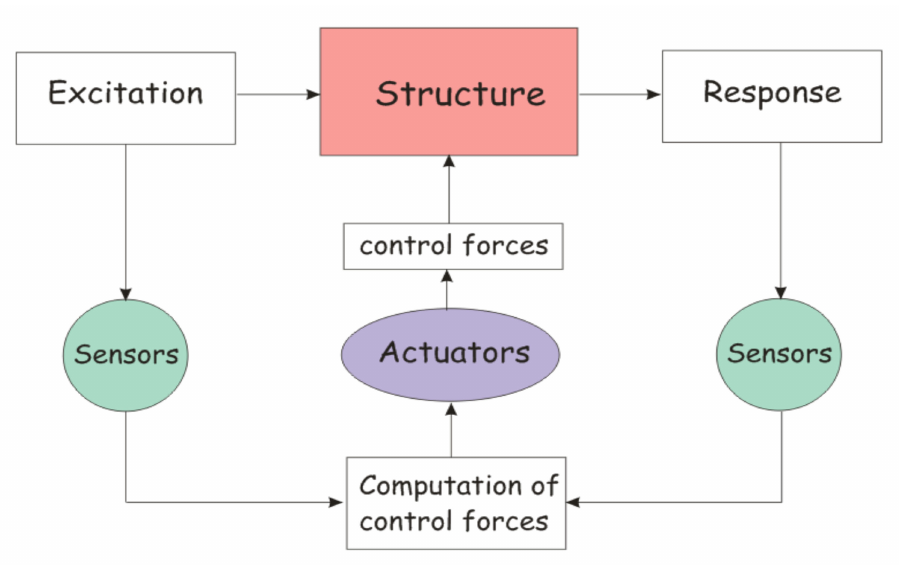
Figure 14. Block diagram of active